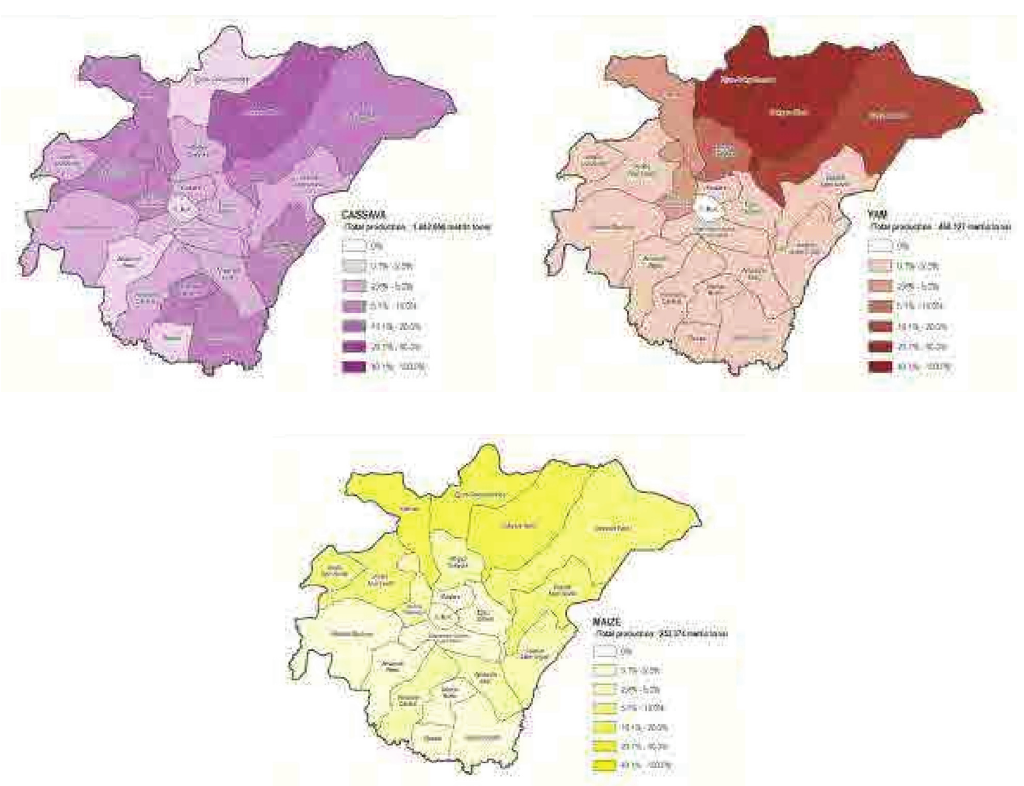
Figure 3: Production of cassava, yam, and maize in the Ashanti Region based on data from MoFA (source: https://openjicareport.jica.go.jp/ pdf/1000014018_01.pdf).